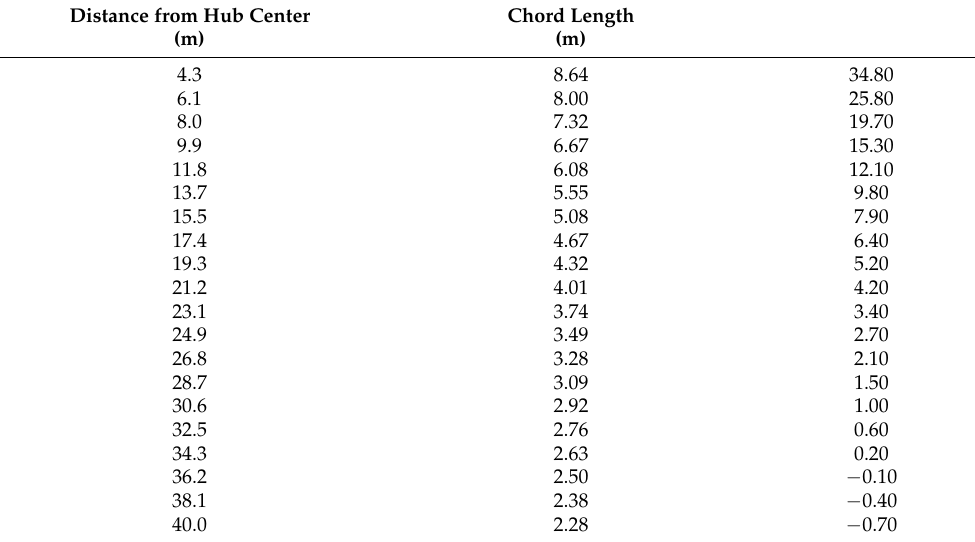
Table 2. Optimum blade geometry, as calculated by TTBEM application